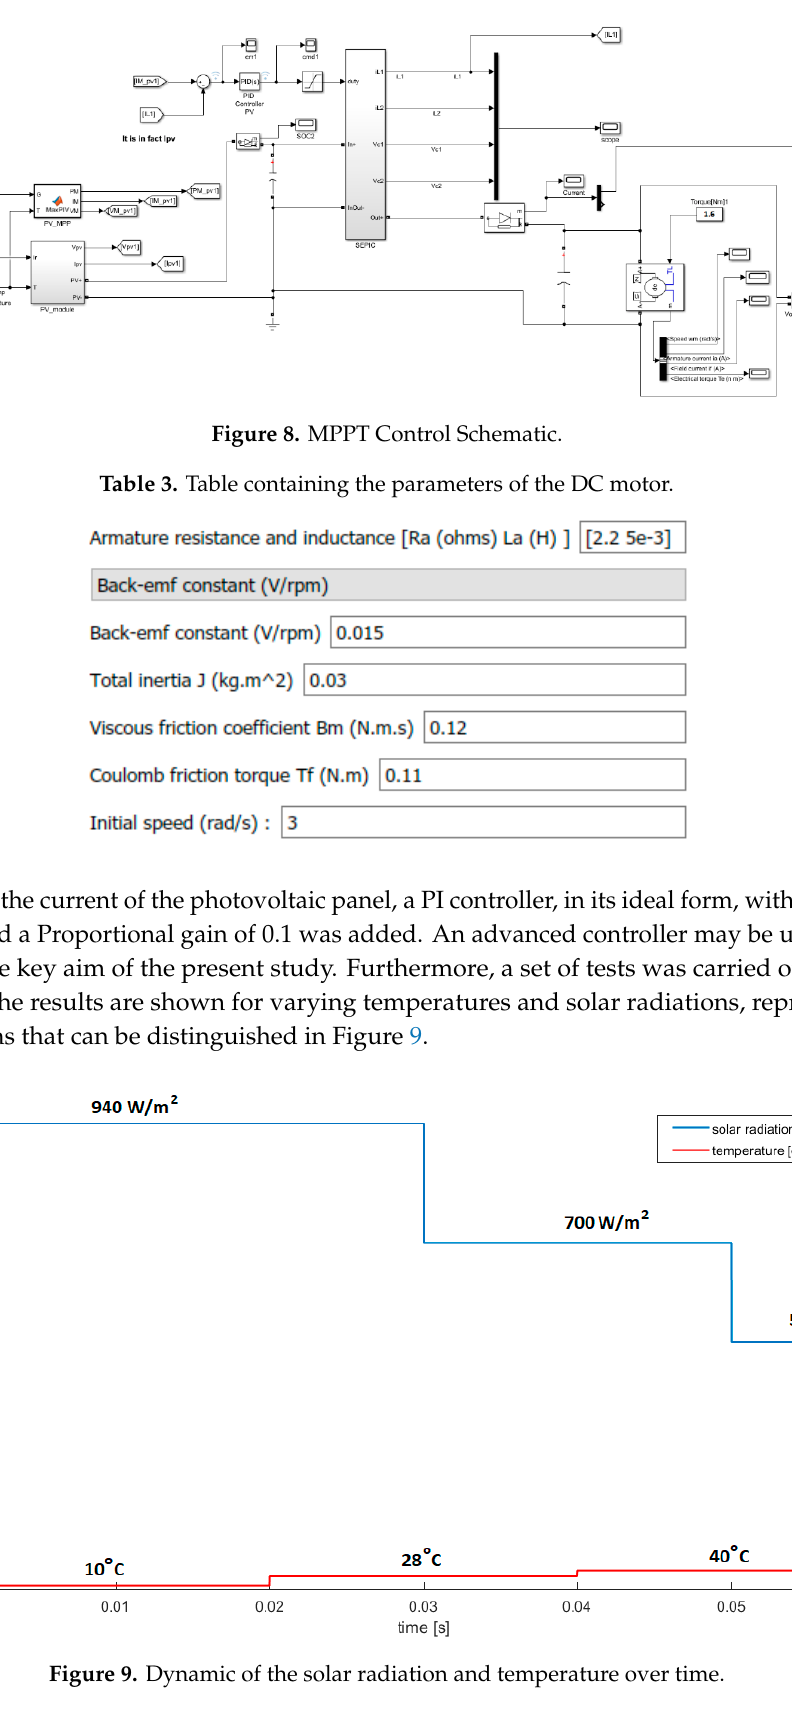
Figure 10. Evolution of PV power over time.